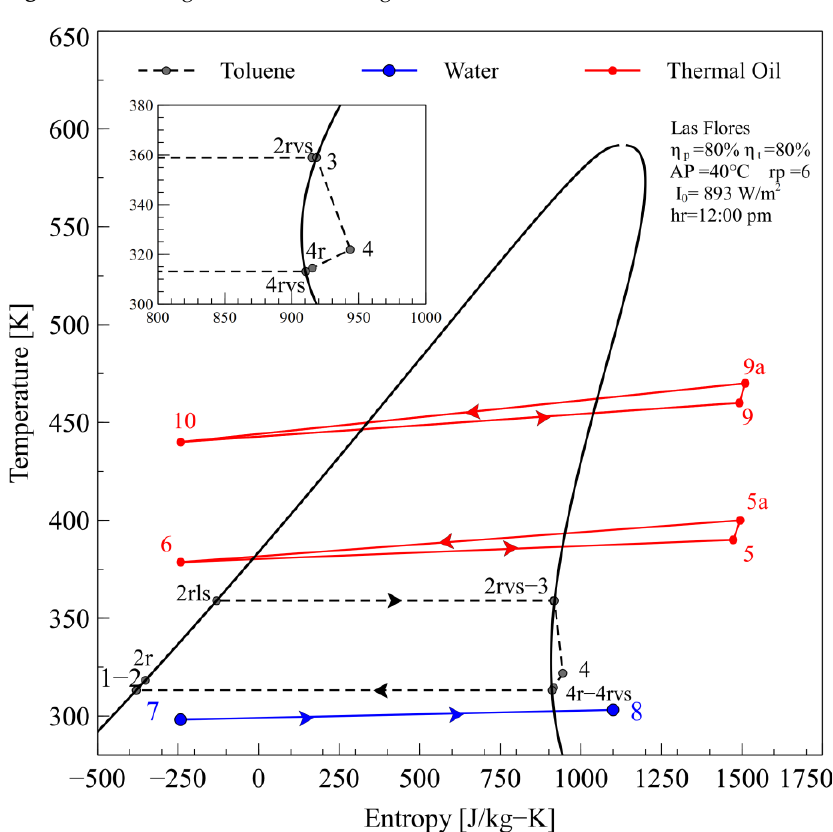
Figure 3. T–S diagram of RORC Figure 3. T – S diagram of RORC configuration.